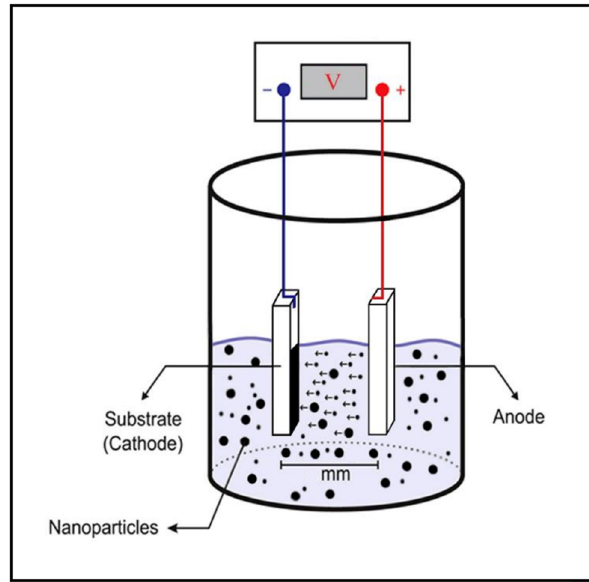
Figure 7: Schematic illustration of the electrophoretic deposition process [ 84 ] . Copyright 2015, ACS.